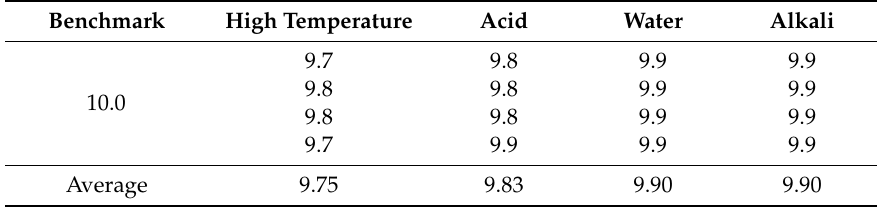
Figure 9. Appearance of carbon fibers after dispersion. Table 2. The weight of carbon fibers after removal silane using different methods. (Unit: g).